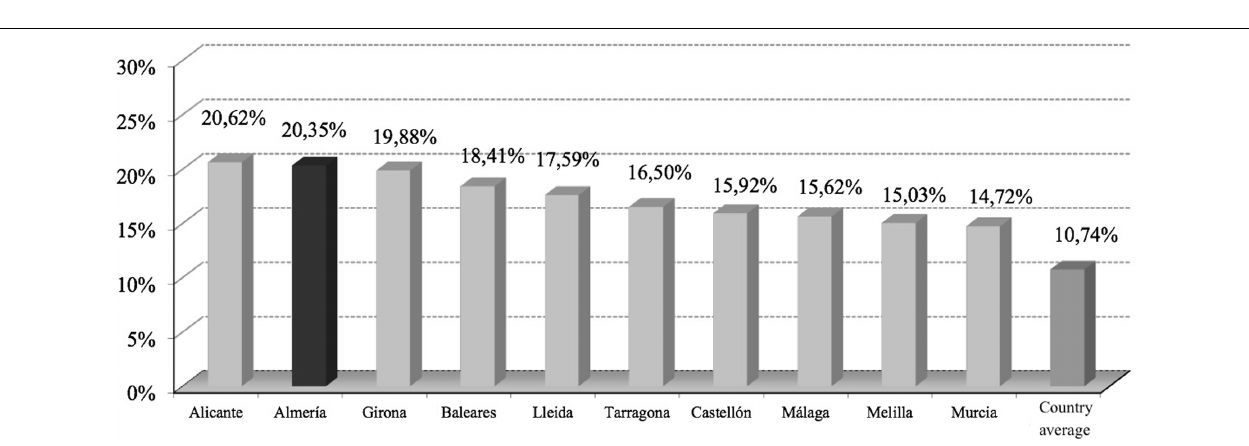
FIGURE 1 | Evolution of the population: Spaniards and foreigners (1998–2015). Source : INE.